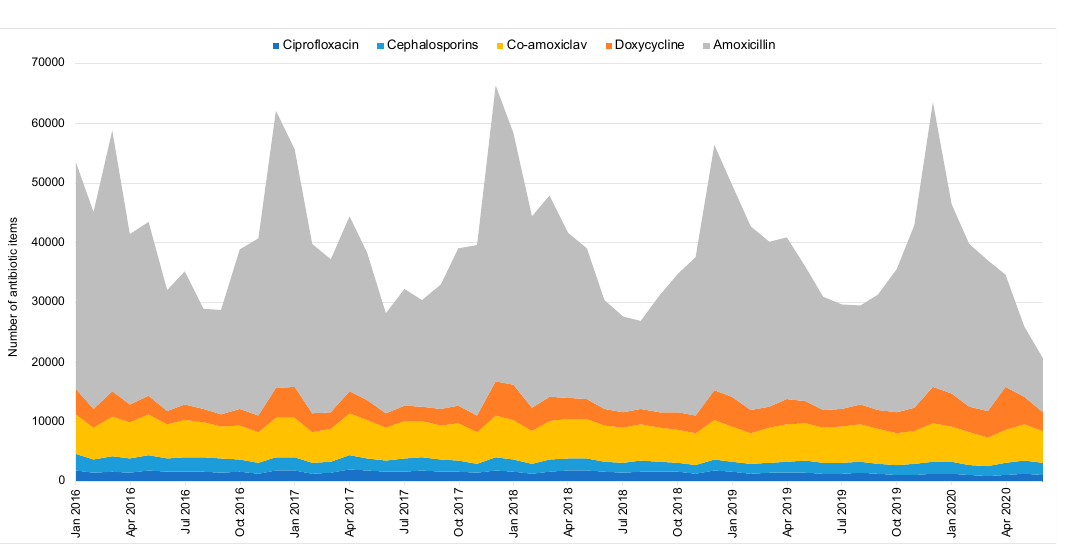
While the OOH prescribing of ciprofloxacin and cephalosporins remained stable within each year, the prescribing of co-amoxiclav, amoxicillin and doxycycline peaked in December every year, with the seasonality indicating a high use of amoxicillin in winter to treat respiratory tract infections (Figure 3). In 2020, the OOH use of co-amoxiclav and doxycycline peaked between March to May, which was out of sync with the seasonality peaks (Winter) in previous years (Figure 3).